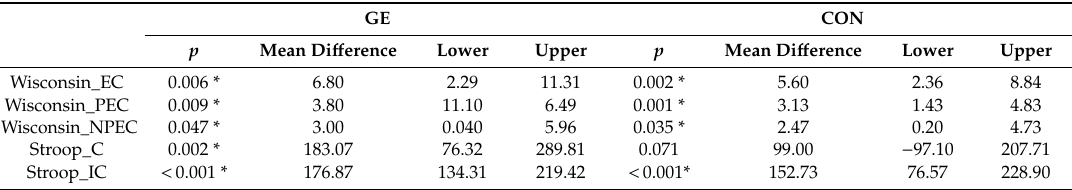
Table 2. Intra group di ff erences in WCST and Stroop as a response to a 30 min exercise protocol with or without superimposed